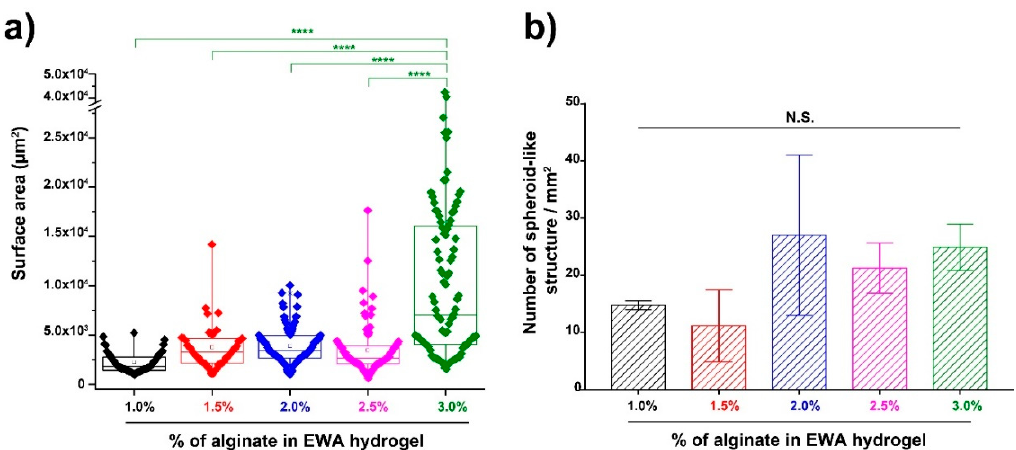
Figure 5. Surface area and distribution of spheroid-like structures formed on EWA hydrogels. ( a ) The surface area (µm 2 ) of each spheroid-like structure found in the EWA hydrogels was measured and compared among EWA containing different alginate percentages. Data were plotted as boxplot using a box limit of 25th and 75th percentiles with a minimum-maximum whisker’s range; **** p < 0.0001. ( b ) The number of spheroid-like structures per square millimeter in the EWA scaffolds were determined and compared among the different alginate concentration samples. Data are presented as mean ± SD, n ≥ 3. N.S. not significant.